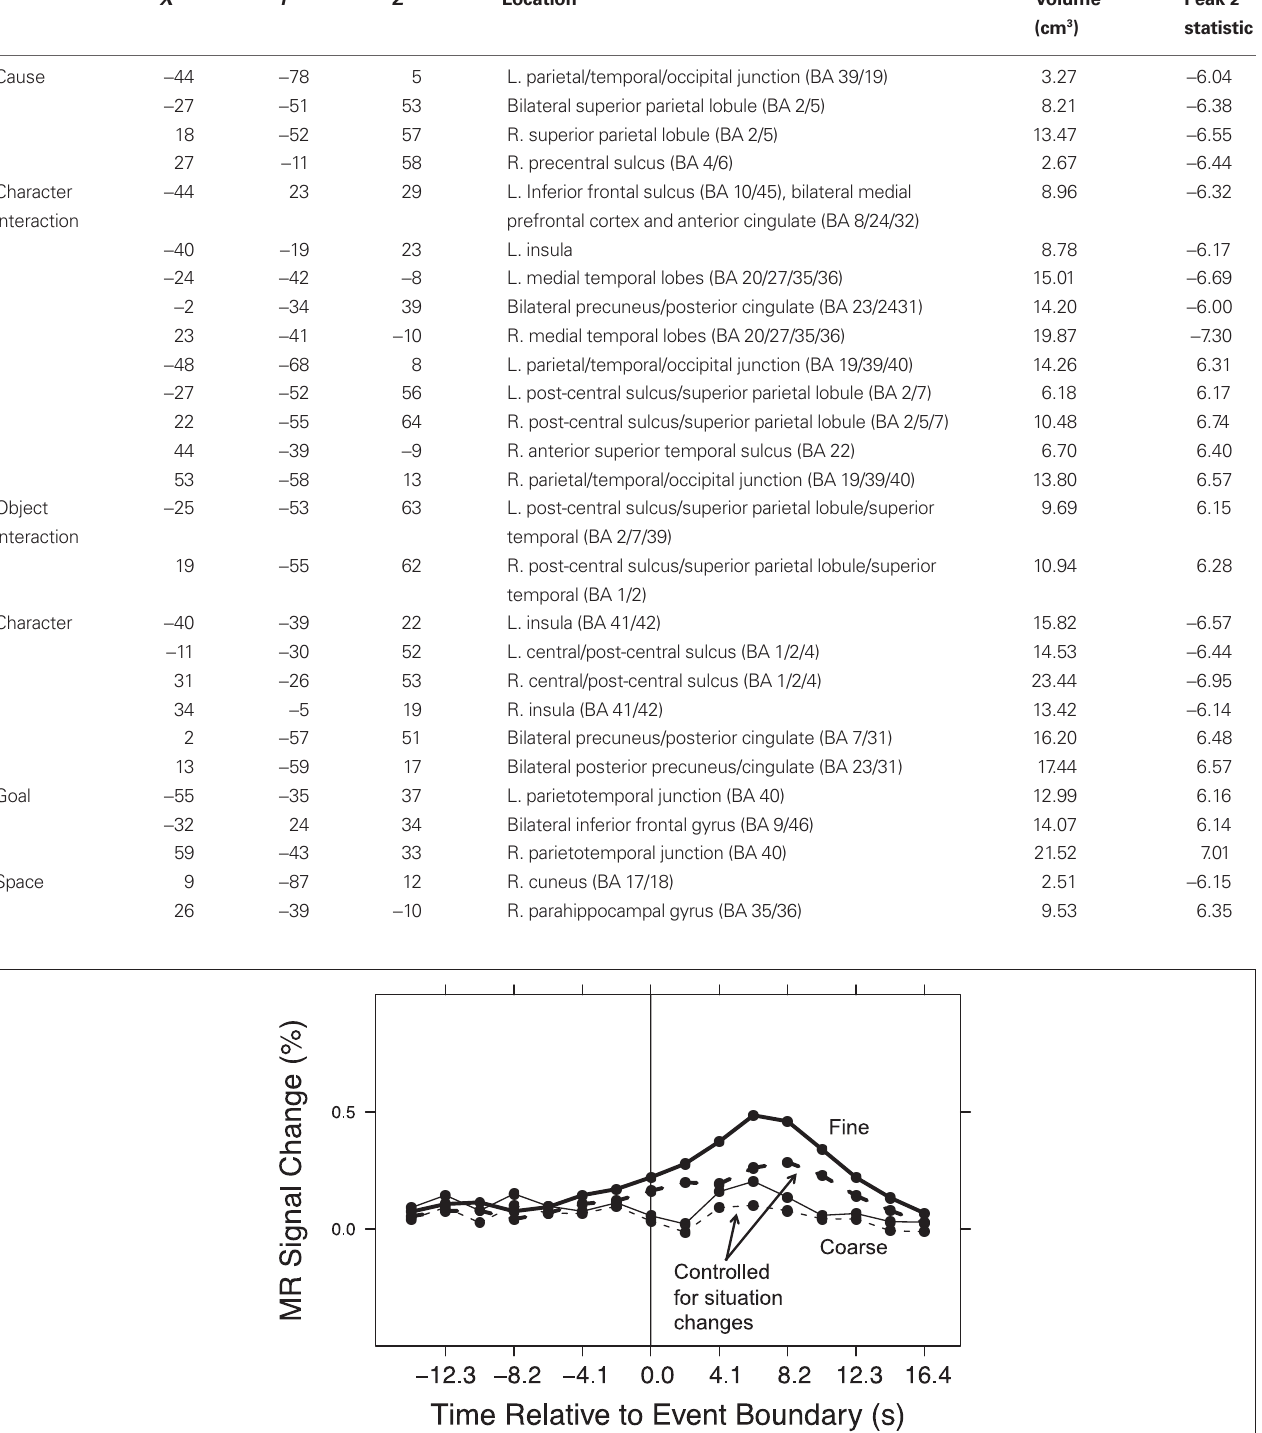
FIguRe 4 | Timecourse of response to event boundaries, before and after controlling for situation changes. Shown here is the mean timecourse for the regions described in Figure 3